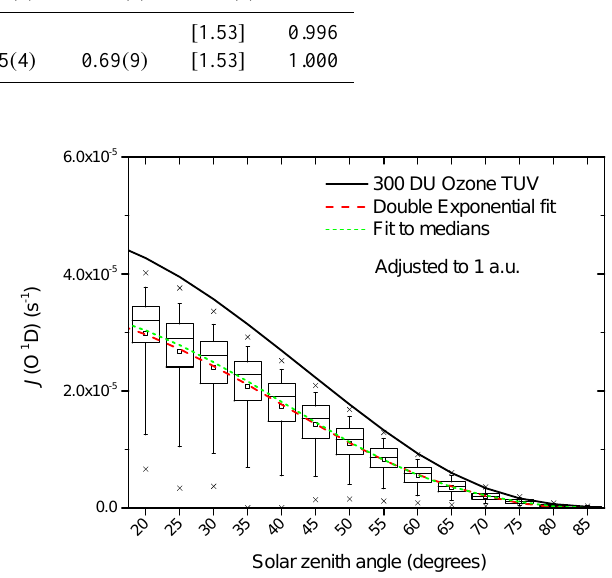
Figure 4. Solar zenith angle dependence of J (O 1 D). Crosses mark the 1st and 99th percentile. The boxes span 25–75%, the whiskers mark 10 and 90%, the central line indicates the median and the square the average value. The x axis value is the central value of the 5 ◦ bin used. The two solid lines were calculated using TUV (V 5.0) for ozone column amounts of 250DU (February) (black solid line) and 350DU (September) (red solid line). The short-dashed green line is the fit of a single exponential term to all data.